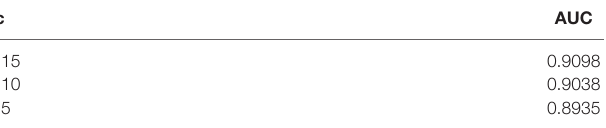
TABle 2 | The AUC of KATZBNRA with c set different values.